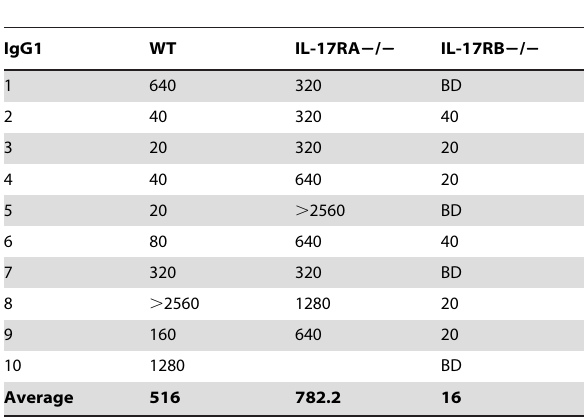
Table 4. H. pylori- specific IgG1 titers in the serum of H. pylori (strain SS1)-infected mice infected for 3 months.